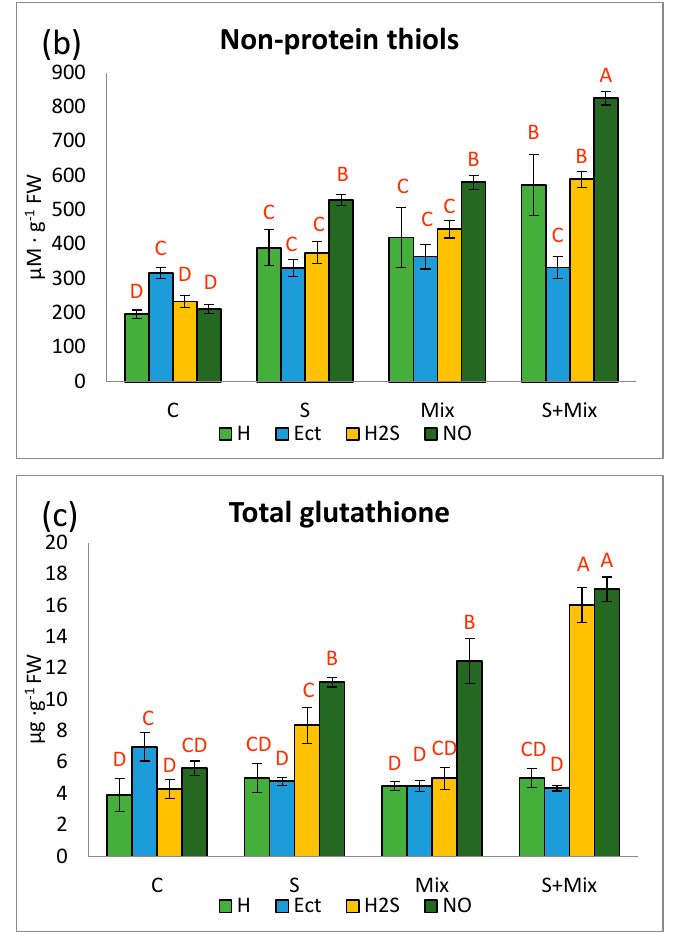
Figure 2. Components of the detoxification system in Lobularia maritima subjected to priming prior to stress exposure: ( a ) activity of glutathione S-transferase GST; ( b ) the content of non-protein thiols; ( c ) total content of glutathione GSH. Upper case letters indicate statistical significance of means acc. two-way ANOVA. Applied primers: H-water (hydropriming), Ect-ectoine, H2S-hydrogen sulfide donor GYY4137, NO-nitric oxide donor sodium nitroprusside. Treatments: C-control; S-low salinity (20 mM NaCl); Mix-metals: 0.7 mM ZnSO 4 , 16 µM CdCl 2 , 3 µM PbCl 2 ; S + Mix-salinity combined with metals.